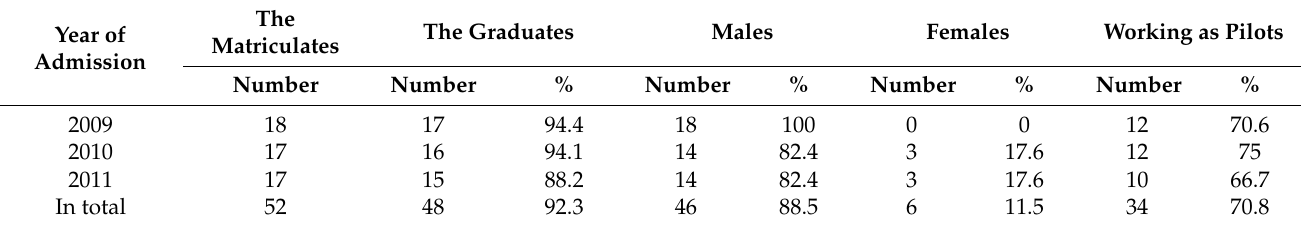
Table 1. Descriptive statistics of the graduates (source: created by the